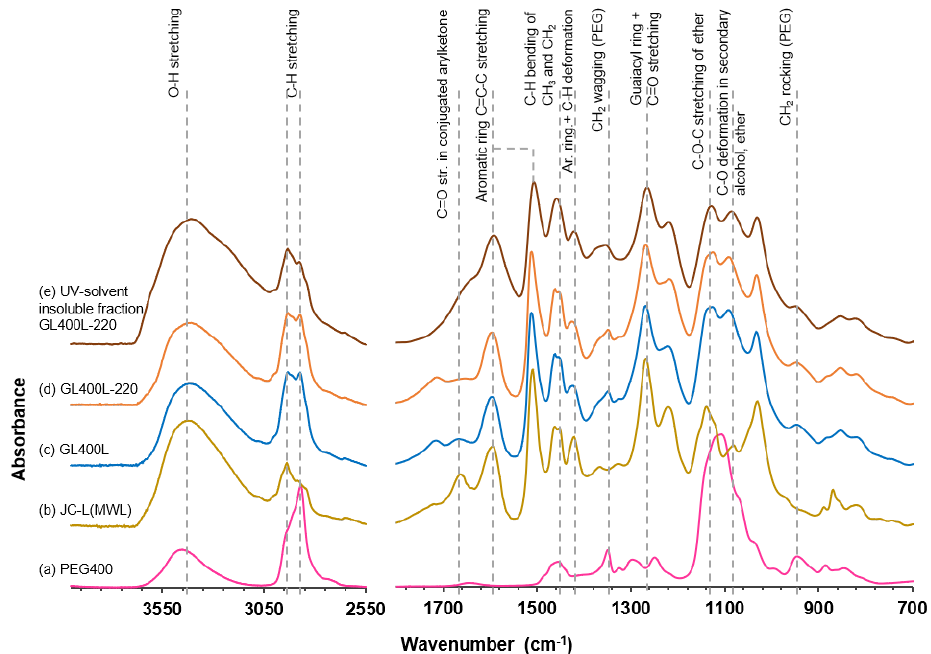
Figure 2. ATR-FTIR spectra of PEG400 ( a ), milled wood lignin (MWL) extracted from JC wood meal (JC-L) ( b ), GL400L prepared from acid-catalyzed PEG400 solvolysis of wood meal (JC-L) ( c ), GL400L after heat treatment at 220 °C for 1 h, (GL400L-220) ( d ), and the fraction of heat-treated GL400L-220 that is insoluble in the solvent (2-propanol:0.2M NaOH, v / v :1/1) used for UV lignin analysis ( e ).